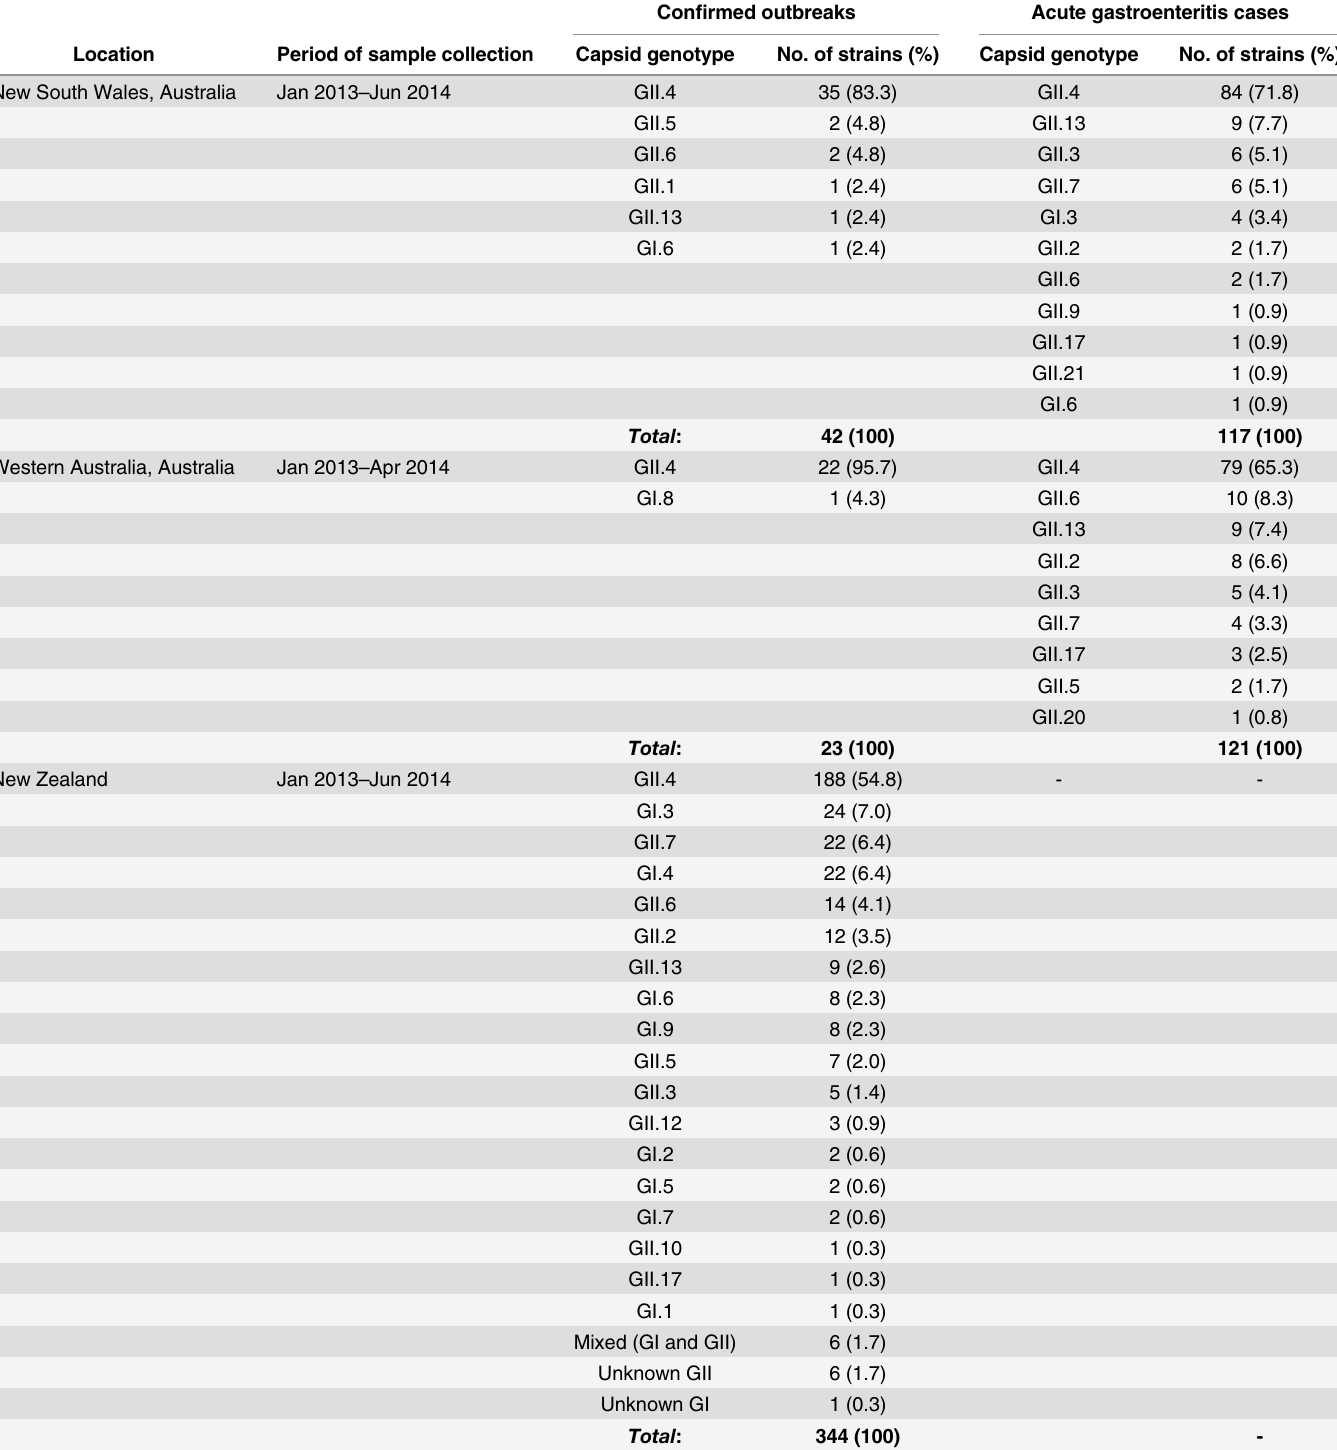
Table 1. Summary of NoV genotypes identified in Australia and New Zealand during 2013 –